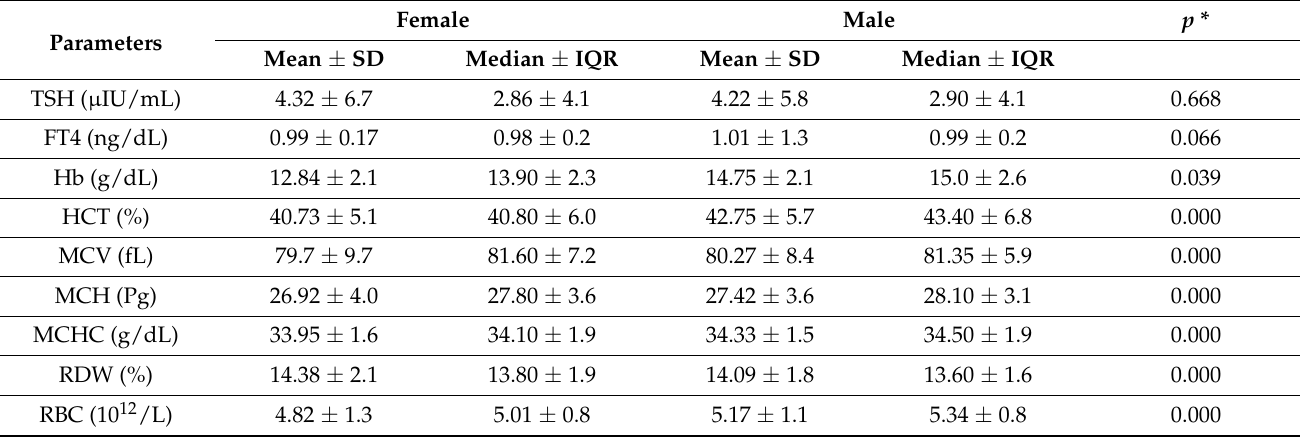
Table 2. Characteristics of the study population stratified by